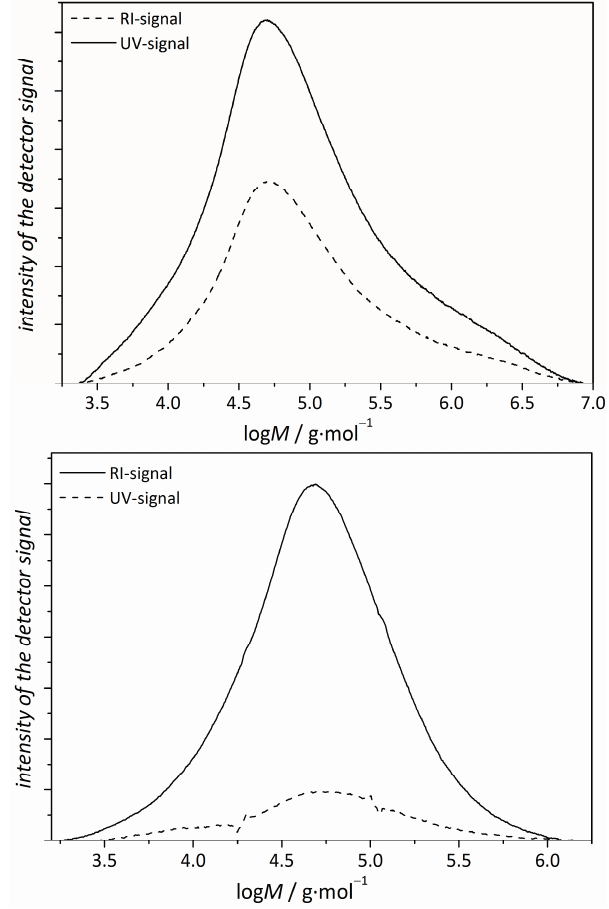
Figure 13. ( Top ) RI- and UV-chromatograms (at 310 nm) after the cross-linking; ( Bottom ) RI- and UV-chromatograms (at 310 nm) after the